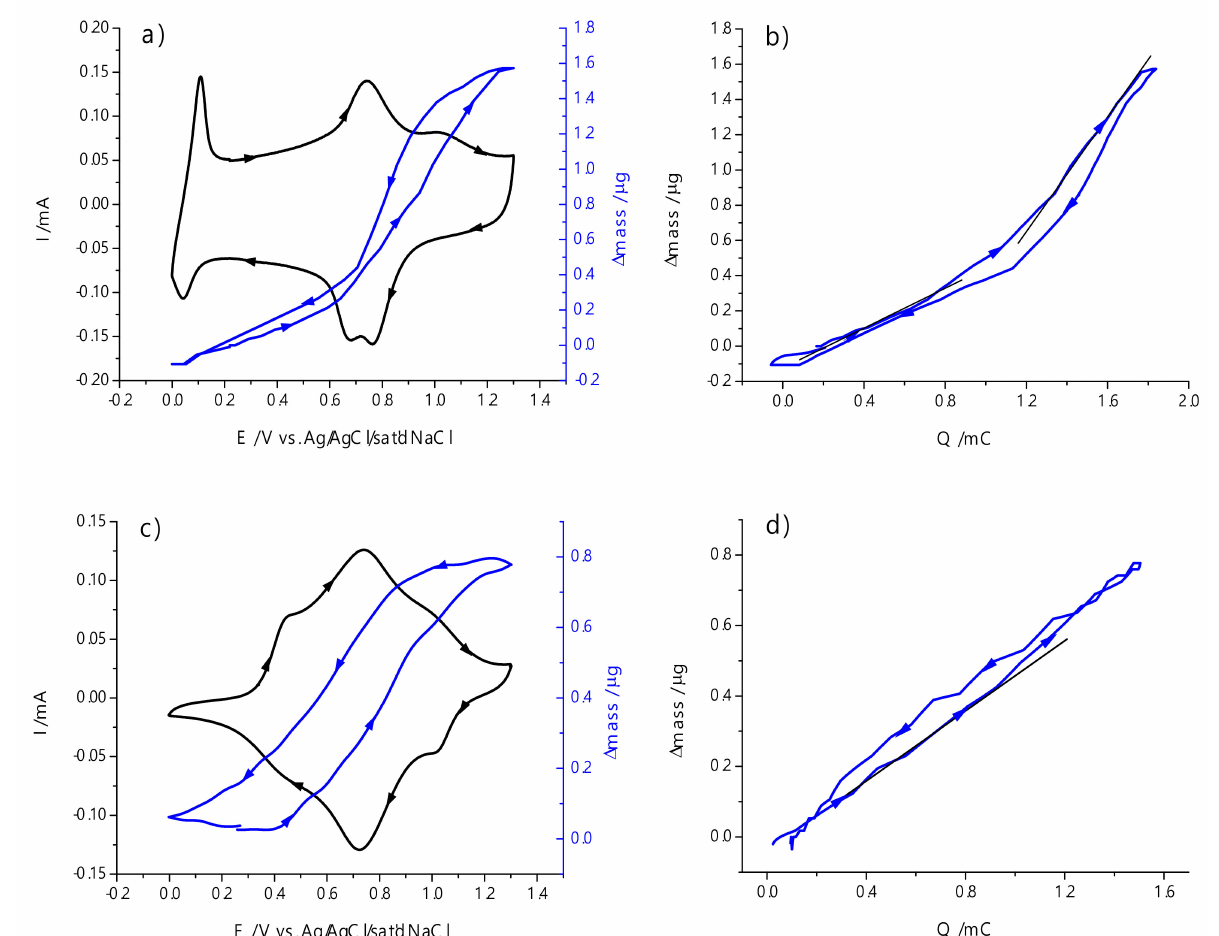
Figure 5. The change in the polymer film mass as a function of potential (blue line), cyclic voltammo- grams (black line) and corresponding ∆ m(q) curves for poly-Ni(3-MeOSalen) ( a , b ) and poly-H 2 (3- MeOSalen) ( c , d